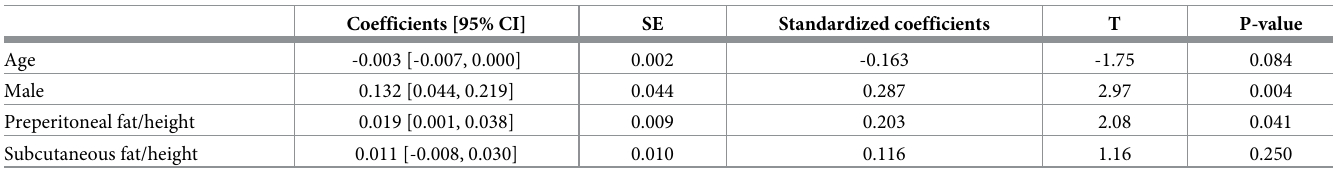
Table 8. Multiple regression analysis based on ultrasound data (60 min after the surgical incision).